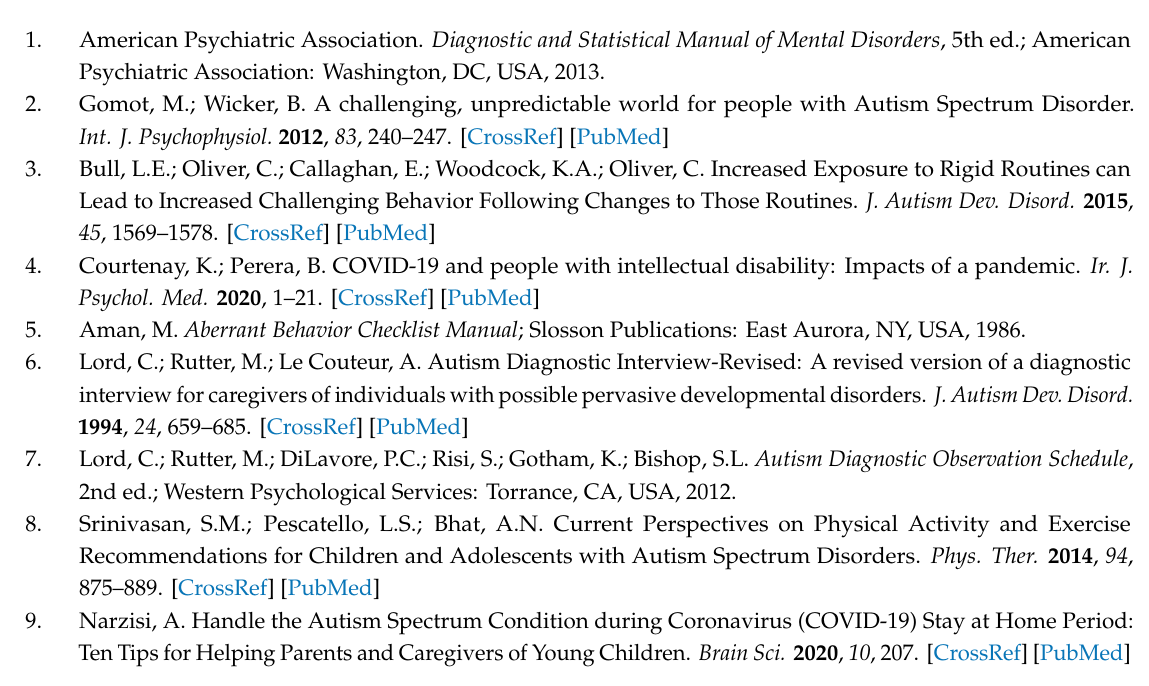
Table S1: additional information about the